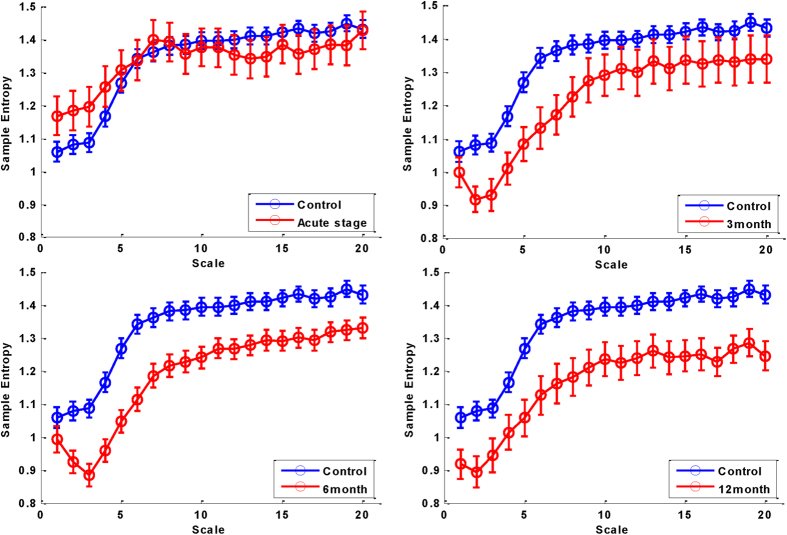
MSE in the control and STEMI patients at different time points.(A) Acute stage of MI, (B) 3 months after MI, (C) 6 months after MI, (D) 1 year after MI. Data are expressed as median (circle) and standard error of the mean (bar).